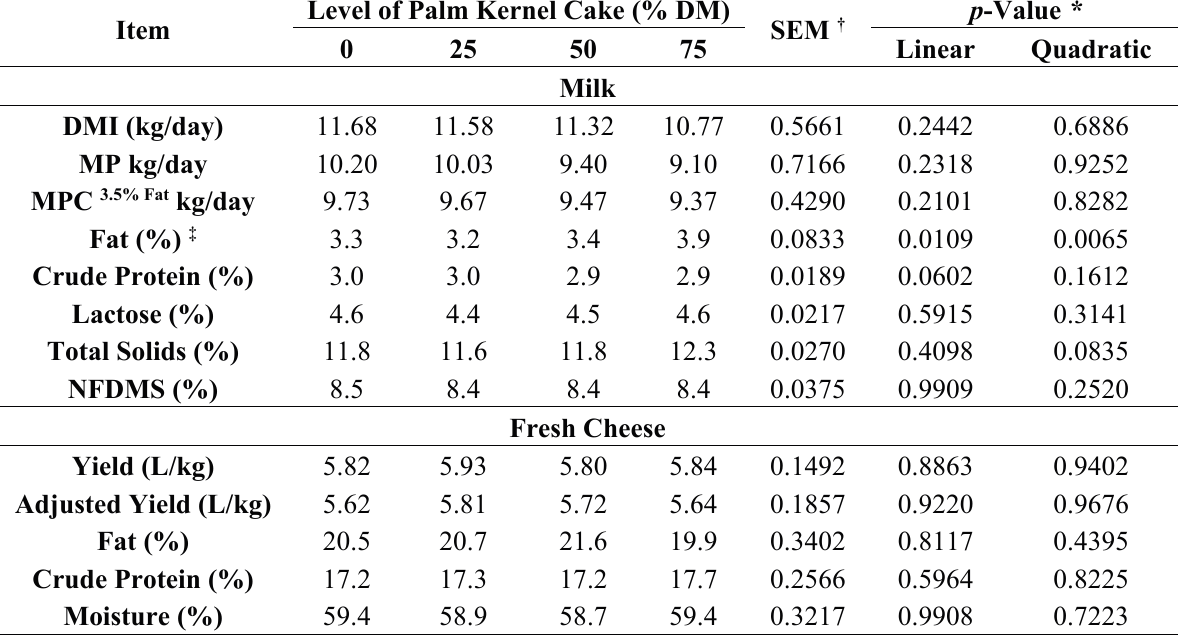
the production of milk corrected for 3.5% fat (MPC), fresh cheese yield (L/kg), fresh cheese adjusted yield (L/kg) and chemical composition of milk and fresh cheese produced by cows fed with different palm kernel cake